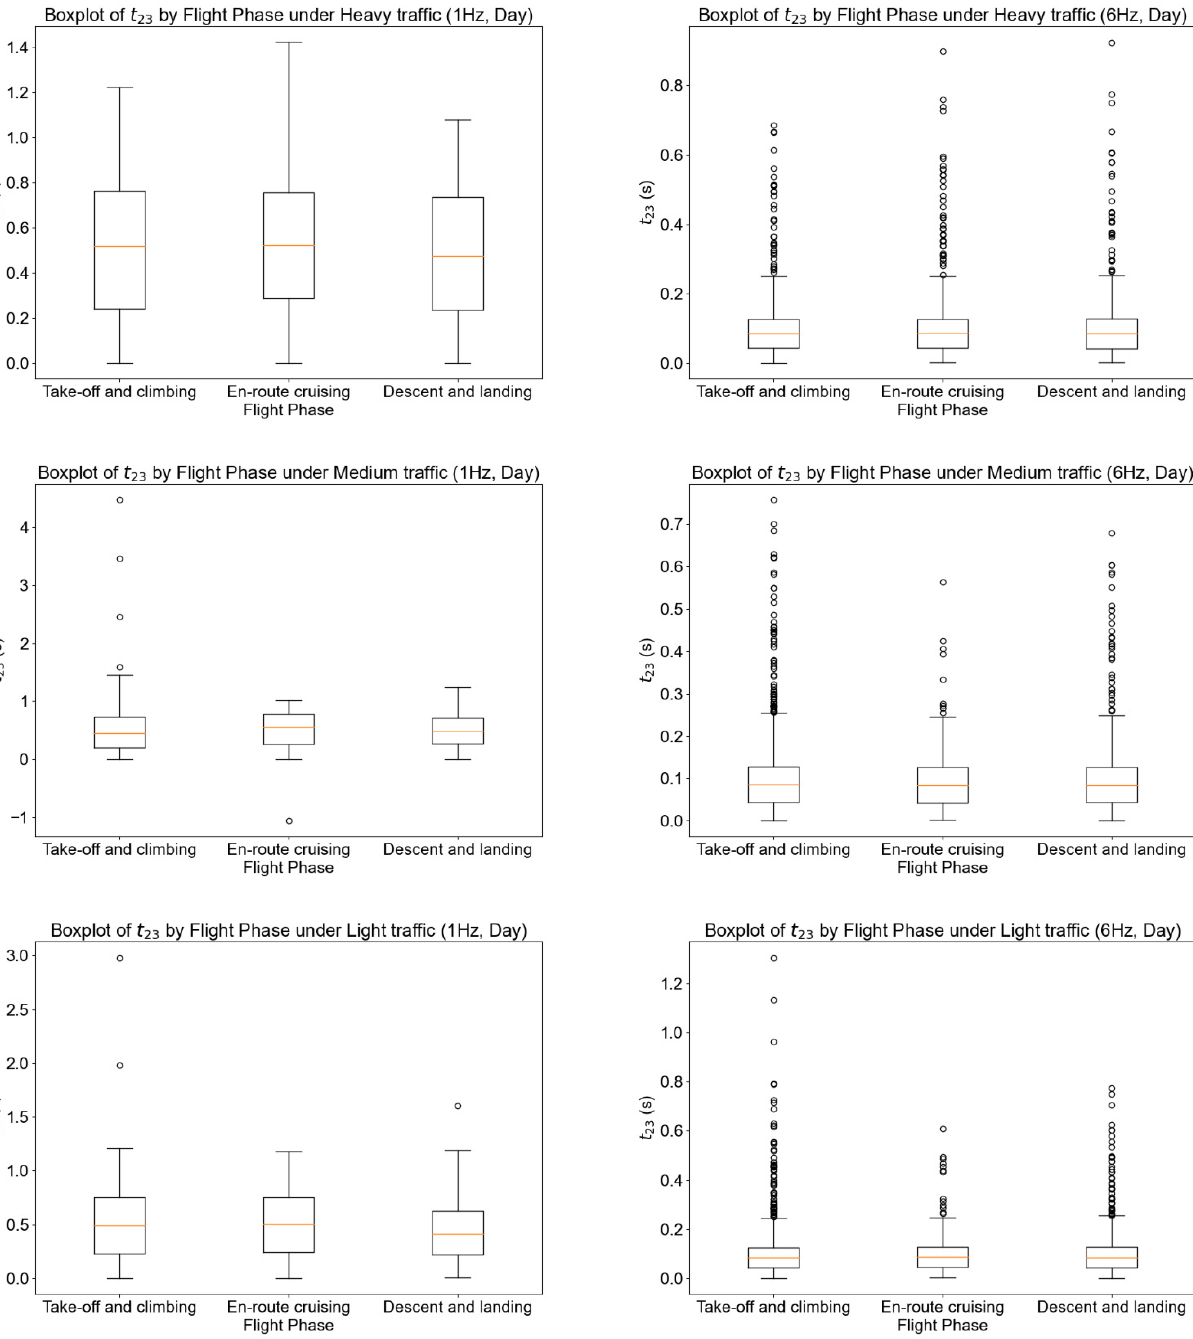
Figure A3. The boxplots of 𝑡 (cid:2870),(cid:2871) during daytime setting.